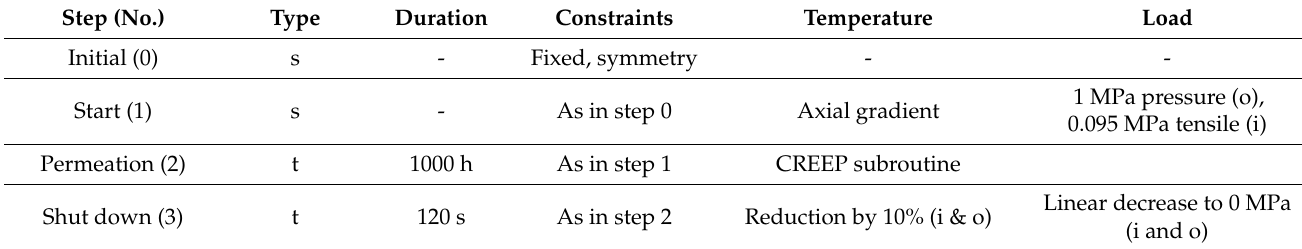
Table 2. Steps and corresponding parameters in the